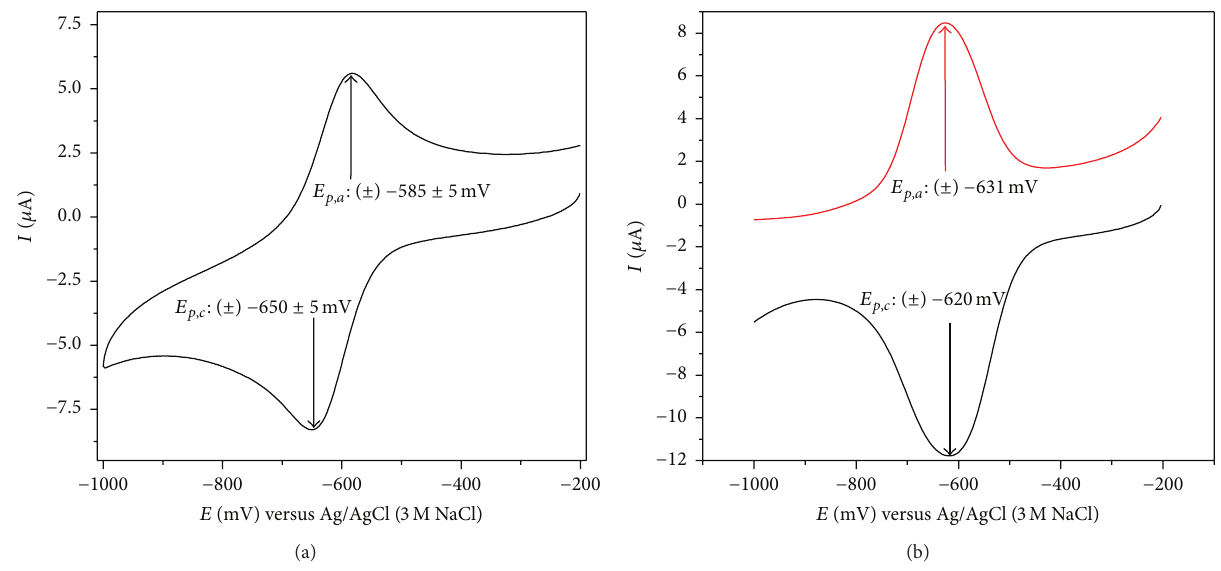
Figure 4: Cyclic (a) and square wave (SW) (b) voltammograms of CYP3A4-based biosensor in argon-saturated PBS (pH 7.4, 100 mM KCl) containing 1mM Co(Sep) 3+ in solution. The biosensor contained 1.63 𝜇 M CYP3A4.